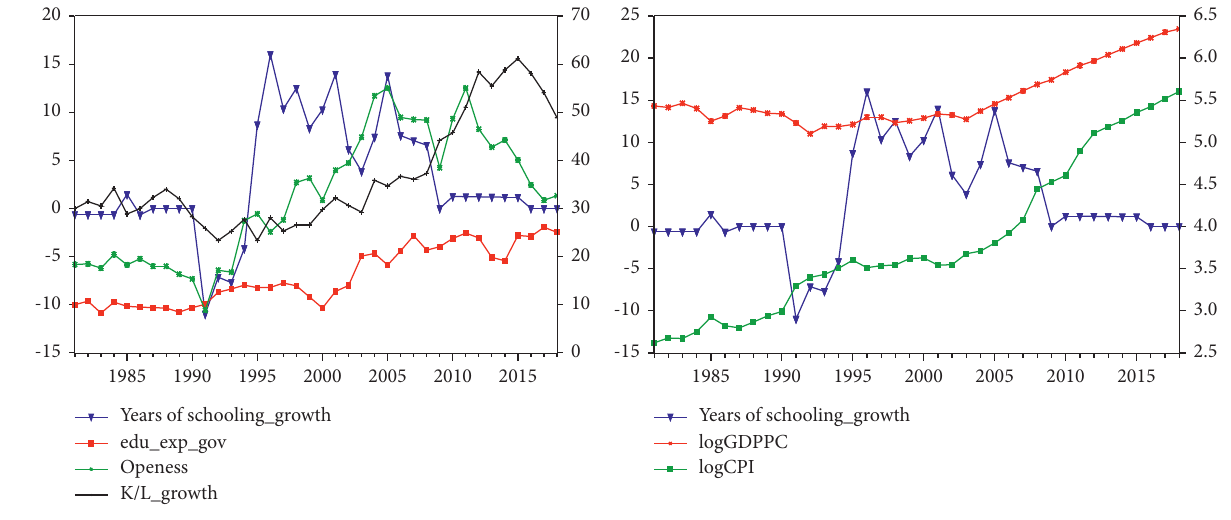
Figure 1: Trends of selected variables. Table 1: ADF unit root test with a structural break.